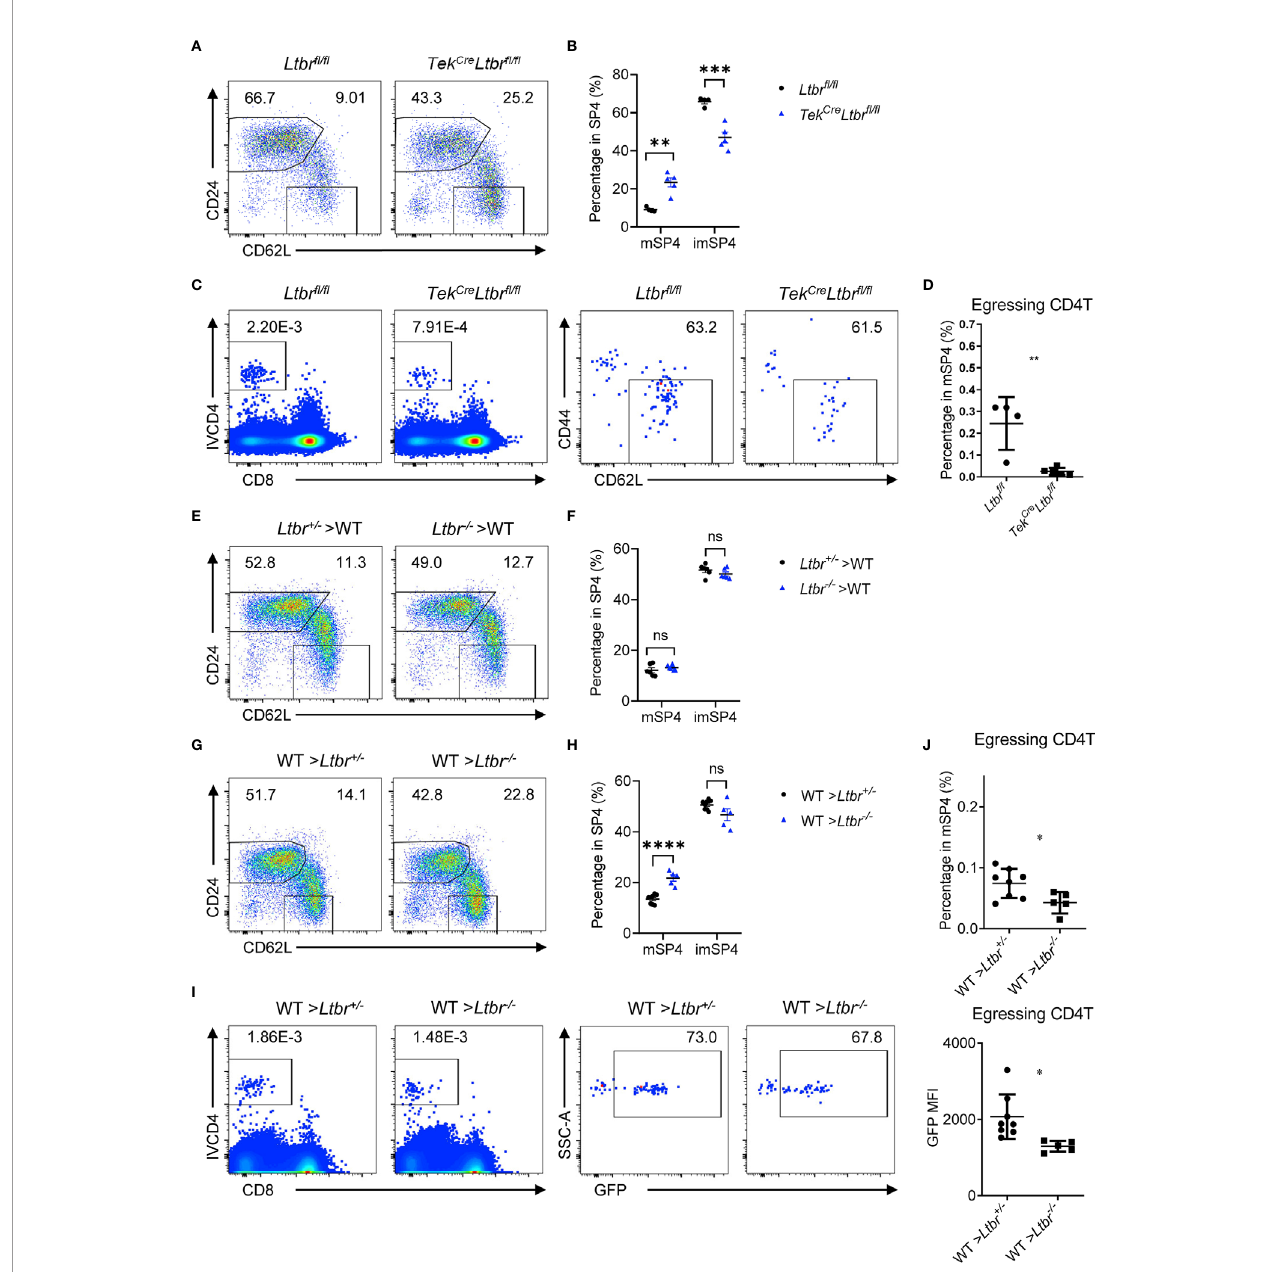
FIGURE 3 | EC-derived LT b R regulates thymic egress. (A, B) Flow cytometric analysis of SP4 thymocytes in Tek Cre Ltbr fl / fl and littermate control mice. (A) Representative dot plots are shown. (B) The graphs display the statistical analysis of the percentage of immature or mature CD4 + SP thymocytes among total SP4 population. Mean ± SEM; n = 4 and 5. Data are representative of at least three independent experiments. (C, D) Flow cytometric analysis of egressing CD4 + T cells in Tek Cre Ltbr fl / fl and littermate control mice. (C) Representative dot plots of IVCD4-labeled thymocytes are shown (left). Egressing CD4 + T cells are gated from IVCD4-labeled thymocytes (right). (D) The graphs display the statistical analysis of the percentage of egressing CD4 + T cells among total mSP4. Mean ± SEM; n = 4 and 5. Data are representative of at least three independent experiments. (E, F) Flow cytometric analysis of SP4 thymocytes in bone marrow chimeric mice with LT b R de fi ciency in hematopoietic cells. (E) Representative dot plots are shown. (F) The graphs display the statistical analysis of the percentage of immature or mature CD4 + thymocytes among total SP4 population. Mean ± SEM; n = 6. Data are representative of at least three independent experiments. (G – J) Flow cytometric analysis of thymocytes in bone marrow chimeric mice with LT b R de fi ciency in irradiation-resistant cells. (G) Representative dot plots of SP4 thymocytes are shown. (H) The graphs display the statistical analysis of the percentage of immature or mature thymocytes. (I) Representative dot plots of IVCD4-labeled thymocytes are shown (left). Egressing CD4 + T cells are gated from IVCD4-labeled thymocytes (right). (J) The graphs display the statistical analysis of the percentage (top) and GFP MFI (bottom) of egressing CD4 + T cells. Mean ± SEM; n = 8 and 5. Data are representative of at least three independent experiments. ns, P > 0.05; *P < 0.05; **P < 0.01; ***P < 0.001; ****P < 0.0001 (unpaired Student ’ s t